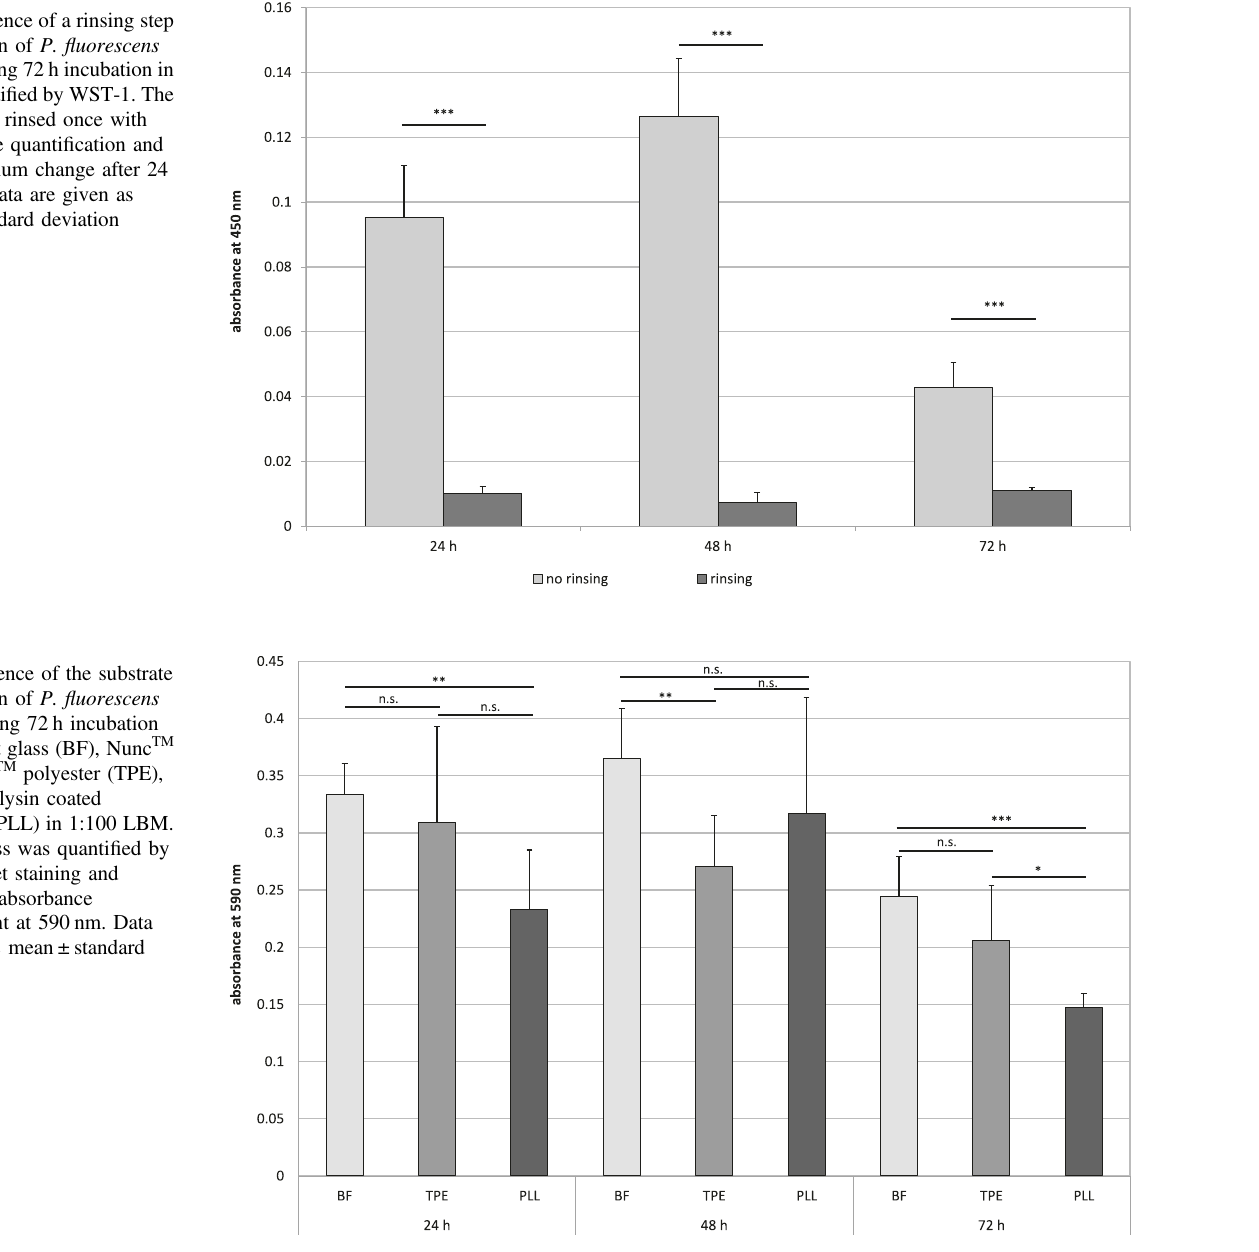
Fig. 6 In fl uence of a rinsing step on formation of P. fl uorescens bio fi lm during 72 h incubation in LBM, quanti fi ed by WST-1. The bio fi lm was rinsed once with LBM before quanti fi cation and during medium change after 24 and 48 h. Data are given as mean ± standard deviation